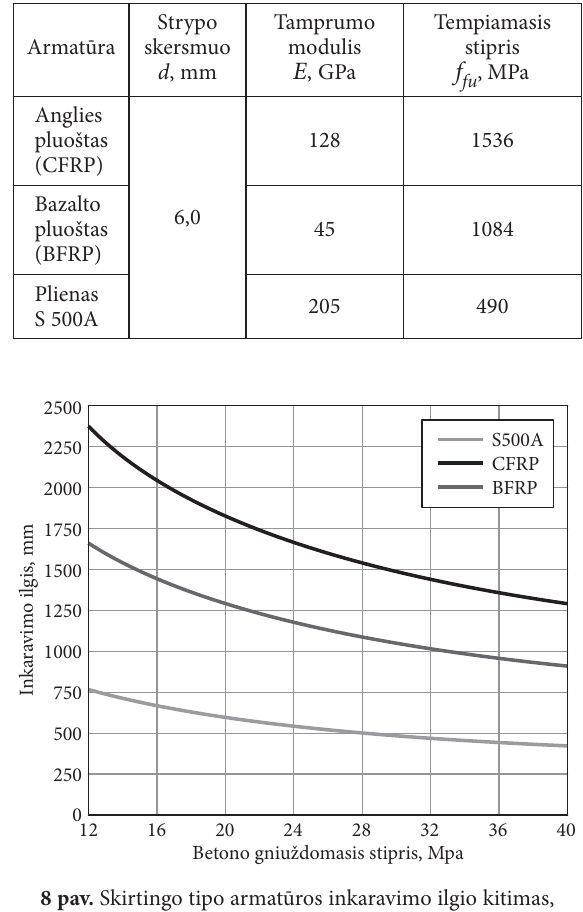
Fig. 8. Eff ect of concrete compression strength on anchorage length when diff erent reinforcement types are